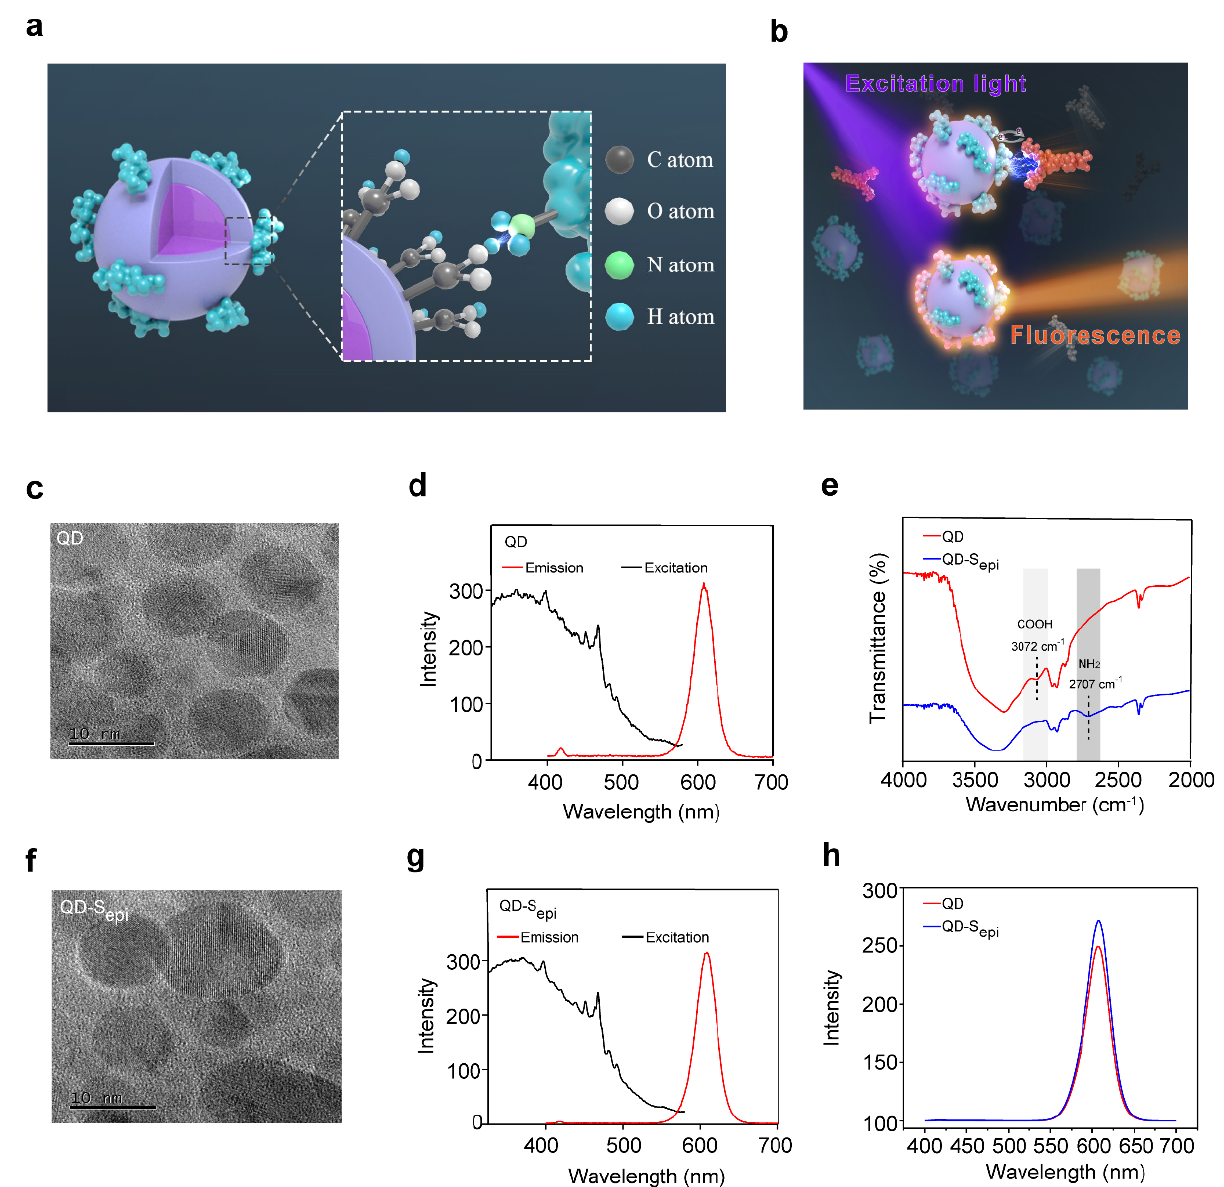
Figure 1. Schematic illustration of QD-peptides detection for the corresponding antibody. ( a ) Schematic of QDs coupled with peptides. The peptides are marked in cyan. ( b ) A schematic diagram of the fluorescent QD-peptides biosensor identifies antibodies by the quantitative fluorescent quenching signal. Purple represents excited light, and orange represents emitted light. TEM ( c ) and emission and excitation spectra ( d ) of the QDs. TEM ( f ) and emission and excitation spectra ( g ) of the QDs coupled with an epitope from receptor-binding-domain (RBD) of SARS-CoV-2 S proteins (S epi ). ( e ) FTIR spectra of the QDs (red line) and QDs coupled with S epi (blue line). The carboxyl peak (COOH; 3072 cm − 1 ) is shown in light grey and the amino peak (NH 2 ; 2707 cm − 1 ) is in dark grey. ( h ) Fluorescence intensity of QDs (red line) and QDs coupled with S epi (blue line). S epi : S epi1 (aa491–505).